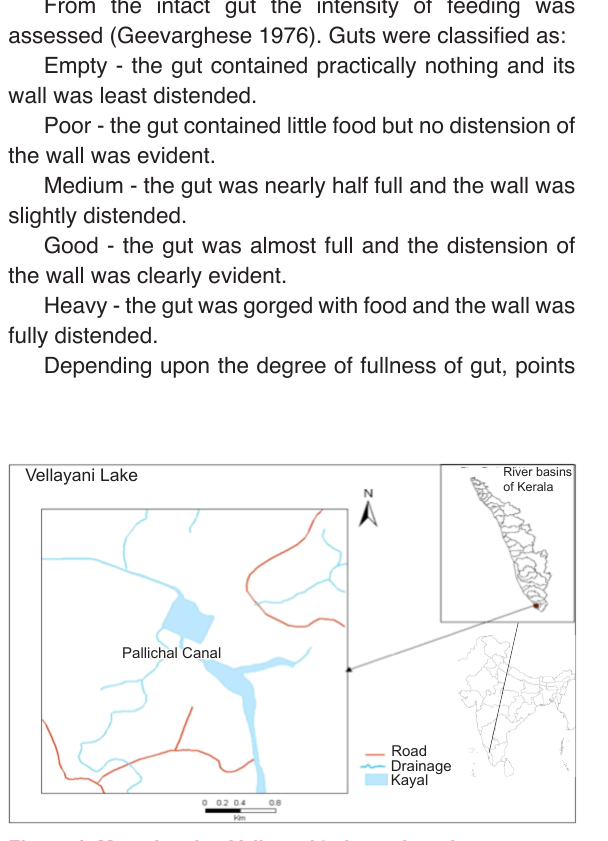
Figure 1. Map showing Vellayani Lake and study area - Pallichal